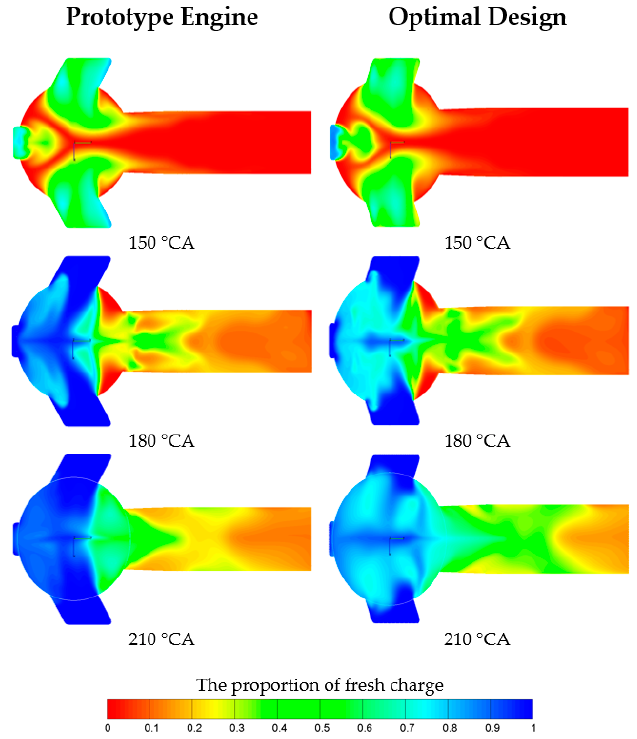
Figure 22. Z cross-sectional views of the prototype engine simulation case and optimal design simulation case under the high load operating condition.